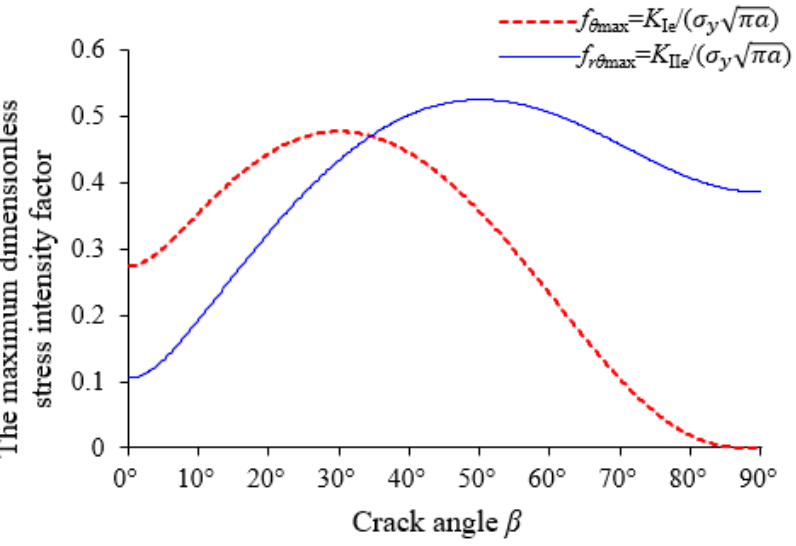
Figure 9. Relationship between the maximum mode-I and mode-II dimensionless stress intensity factors.